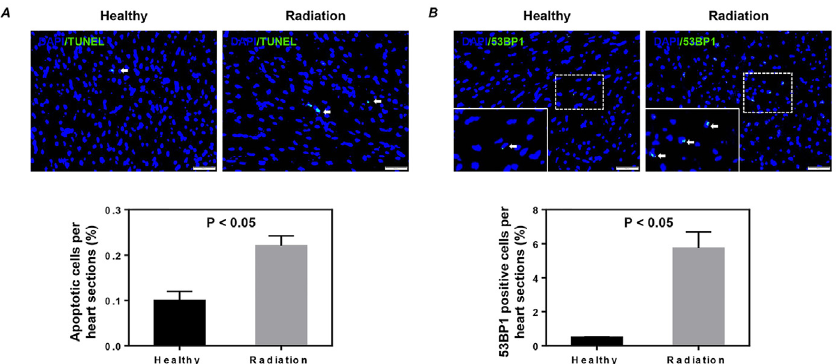
Fig 1. Apoptosis and DNA damage in the heart after whole-body radiation exposure. Apoptosis (A) and DNA damage (B) were detected by TUNEL assay and immunostaining with 53BP1, respectively. Representative images (upper) and quantitative data (lower) are shown. Arrows in (A) and (B) indicate positively stained cells. The nuclei were stained with DAPI. Scale bar: 50 μ m, 20 μ m for magnification. Values shown are the mean ± SEM from 3 independent